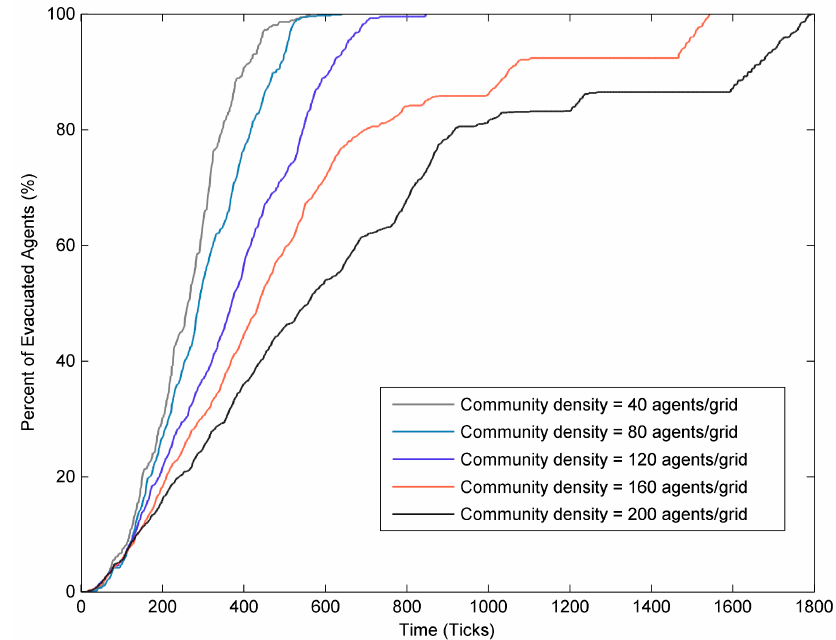
Figure 6. The percent of evacuated agents with time under different community density.